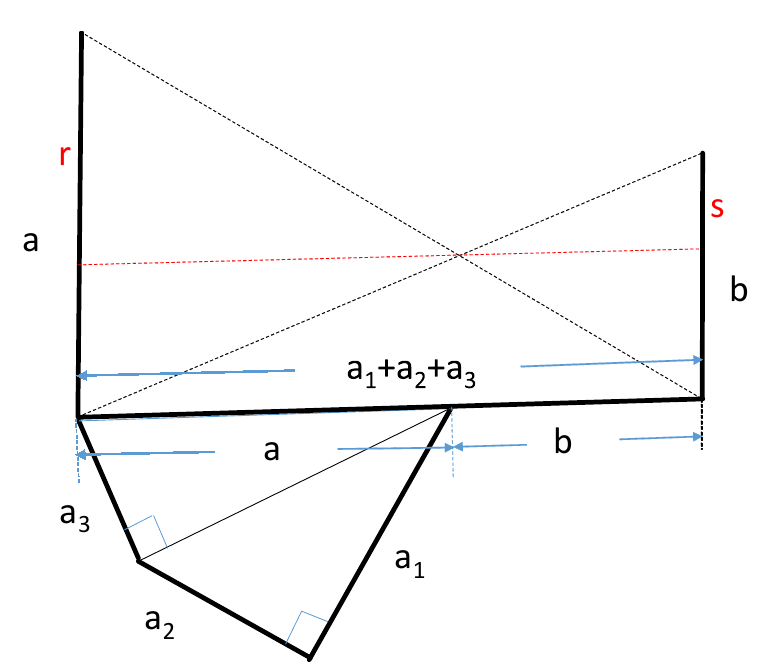
( a ) 1, a 2 , a 3 3 a ; a ( a ) . 1 ; 2 3 3